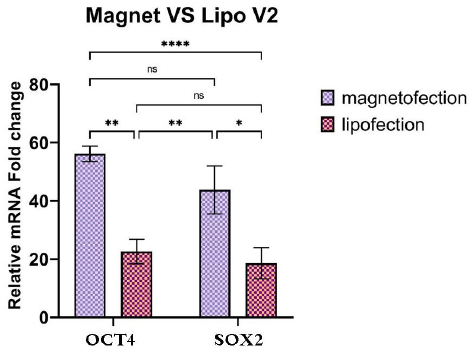
Figure 7. Activation of OCT4 and SOX2 promoters. HFF cells transfected with dCas9VP192 and sgOCT4 and sgSOX2 were analyzed using qRT-PCR 2 days later. dCas9VP192 (control). The asterisks indicate a significant difference (* — p < 0.05, ** — p < 0.01, **** — p < 0.0001), ns; non-significant.